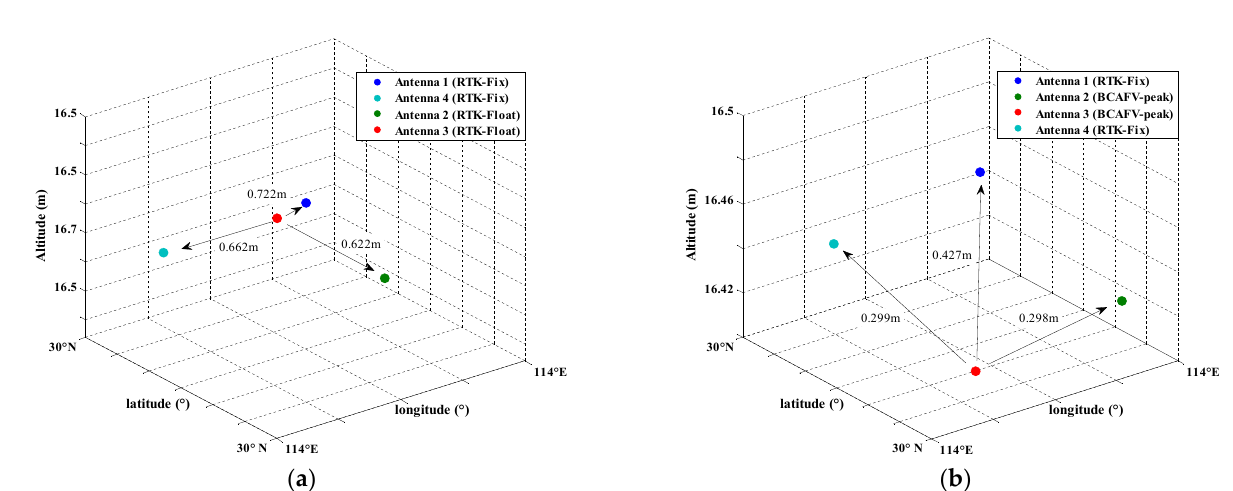
Figure 8. Spatial distribution of four antennas in different positioning modes. ( a ) Antennas 1 and 4 are RTK fixed solution positions and antennas 2 and 3 are float solution positions. ( b ) Antennas 2 and 3 are the positions corresponding to the truth peak.